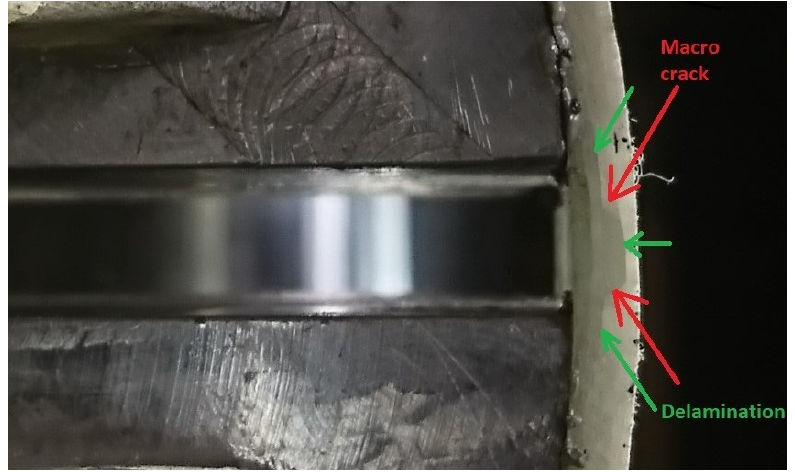
Figure 29. Macro cracks (red arrows) extending through the middle axial layer with delamination on either side of the middle axial layer (green arrows).